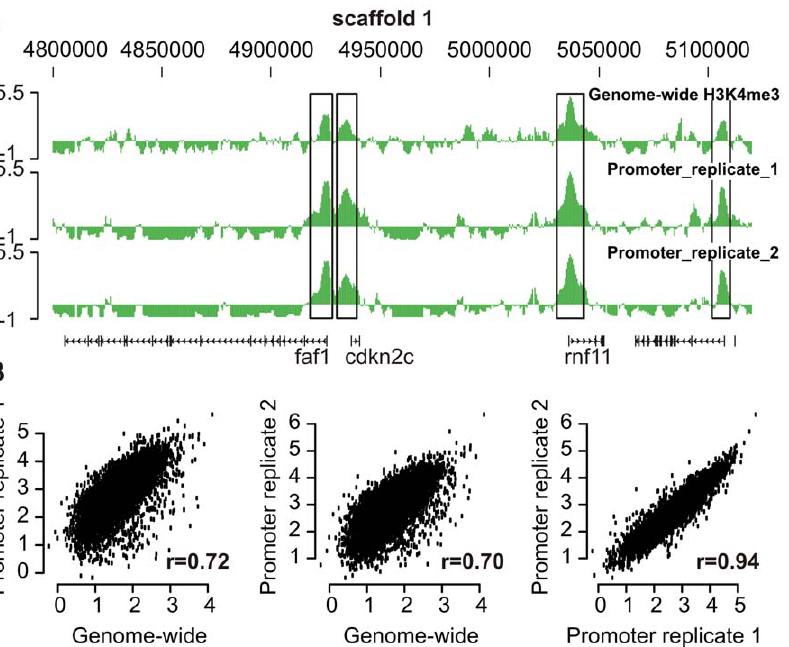
Figure 2. Promoter microarray H3K4me3 ChIP-chip. ( A ) Part of scaffold_1 is visualized using the UCSC Genome Browser. The four H3K4me3 enriched regions; Fas associated factor 1 ( faf1 ), cyclin-dependent kinase inhibitor 2C ( cdkn2c ), ring finger protein 11 ( rnf11 ) and an unknown protein are preserved in the three independent experiments. ( B ) Correlation of the genome-wide tiling and promoter microarray design ChIP-chip experiments; Pearson correlation r=0.72, 0.70 and 0.94 respectively (p , 2.2 * 10 2 16 ).